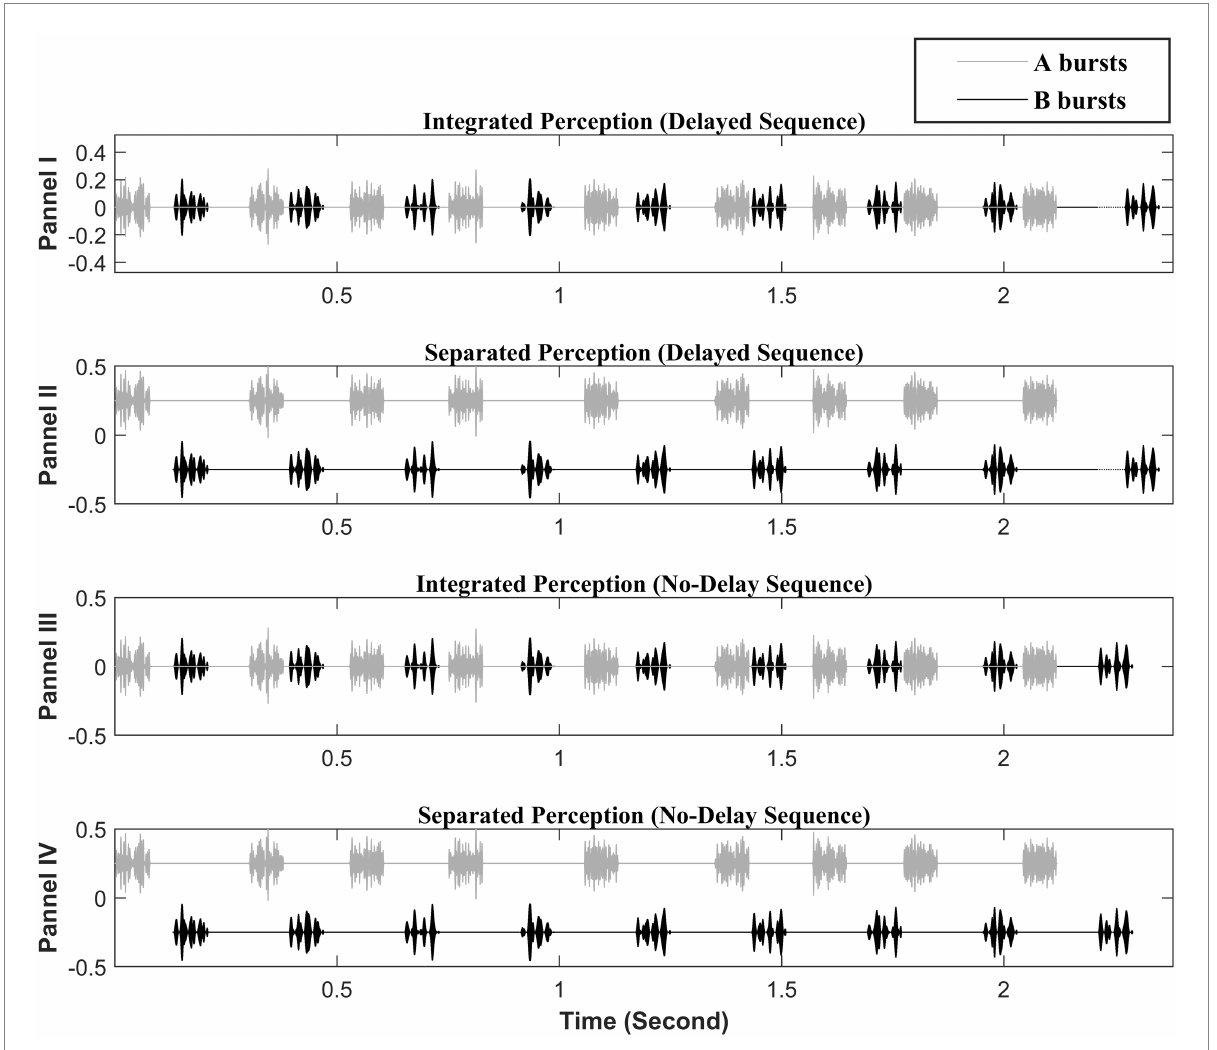
FIGURE 1 Illustration of the stimulus paradigm (adopted from Nie and Nelson, 2015, with permission). The black segments represent the B bursts that form the attended target subsequence. The light gray segments represent the A bursts that form the unattended distracting subsequence. Panels I and II illustrate the delayed sequences: The dark dotted lines to the left side of the last B burst show the delay of 35 ms for the last B burst. Panels III and IV illustrate the no-delay sequences. The I and III panels depict a visual representation of the integrated perception, while the II and IV panels depict the segregated perception. The large A–B spectral separation is depicted here. The AM rates shown on the A bursts and B bursts are 300 Hz and 50 Hz, respectively. The depicted sequences all consist of 9 pairs of A and B bursts with a duration of 80 ms for each burst. The onset-to-onset time between he first A and B bursts is 130 ms consisting of a silent gap of 50 ms between the offset of A and the onset of B. The B–B onset-to-onset time is 260 ms; in other word, the B–B offset-to-onset time is 180 ms as noted in the text. Note, the last eight A bursts are temporally jittered between the two consecutive B bursts resulting in the offset-to-onset gap between an A burst and an adjacent B burst ranging between 10 and 90